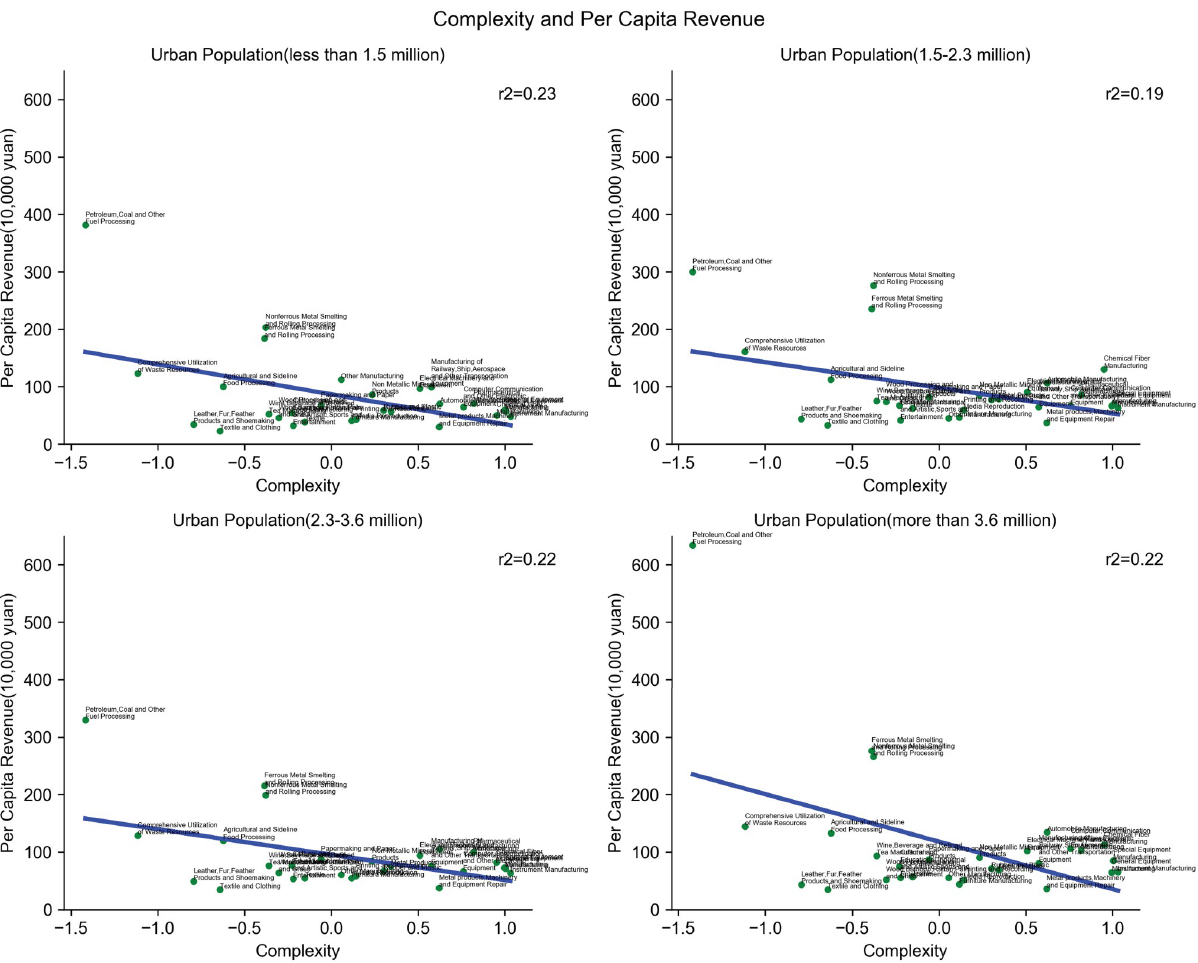
Fig 5. Complexity and average per capita revenue of manufacturing industries by city group. Complexity in the x-axis is measured in the same way as in Fig 4 using the natural logarithm of the ratio of R&D expenditure. Cities are divided into four cities groups. For each industry, we average the Per Capita Revenues for cities within the same group. In the four city groups (urban population “below 1.5 million”,“1.5–2.3”, “2.7–5.4” million, and “5.4 million and above”), the Per Capita Revenue tends to decrease slightly as complexity